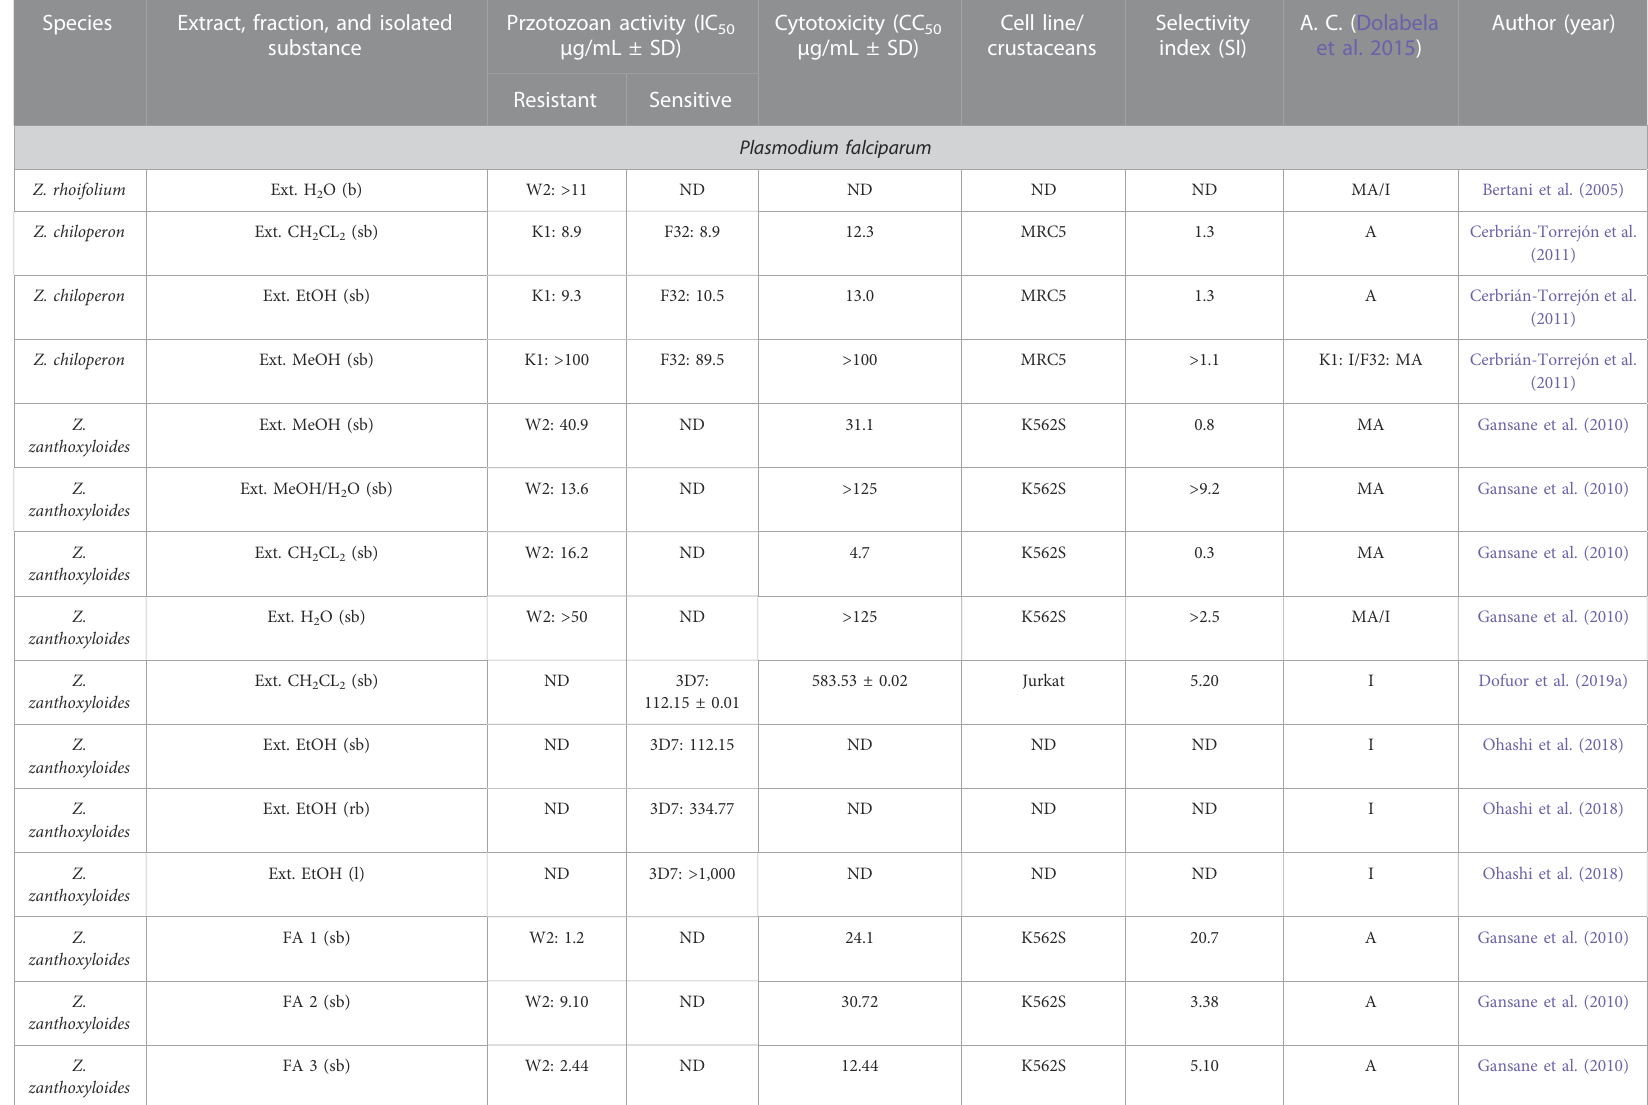
TABLE 3 In vitro antiparasitic activity against